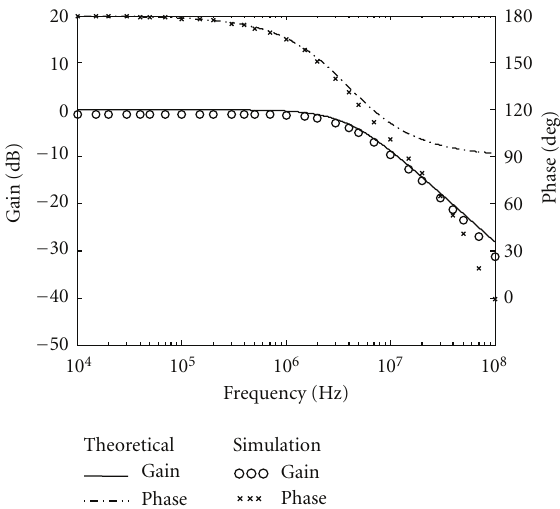
Figure 5: Simulation results of the proposed current-mode first- order allpass filter.